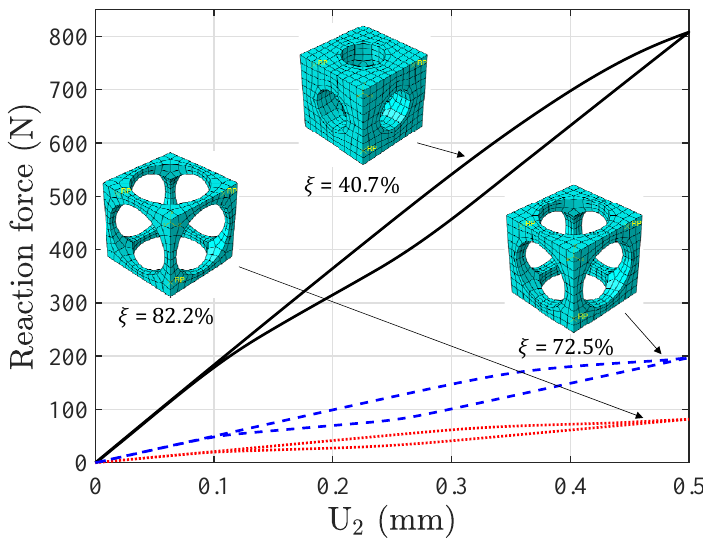
Figure 17. Force-displacement curve of the boundary Z = 20 mm, Y = 0 mm on the bending beam.